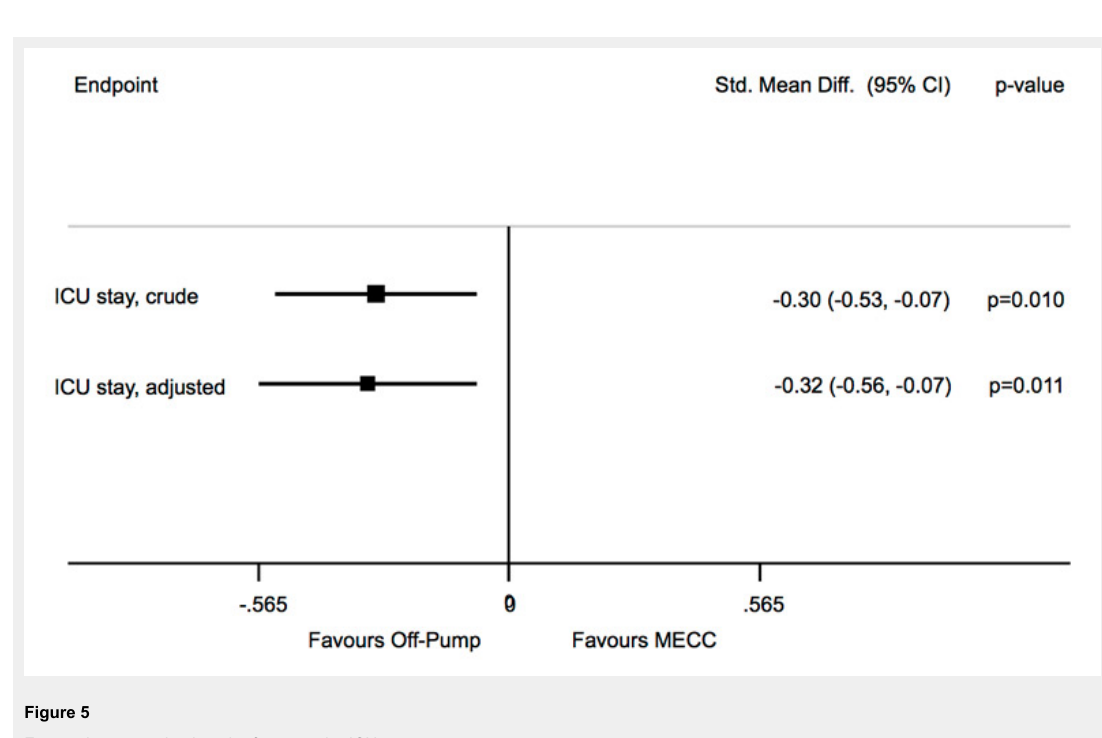
Figure 5 Forest plot comparing length of stay on the